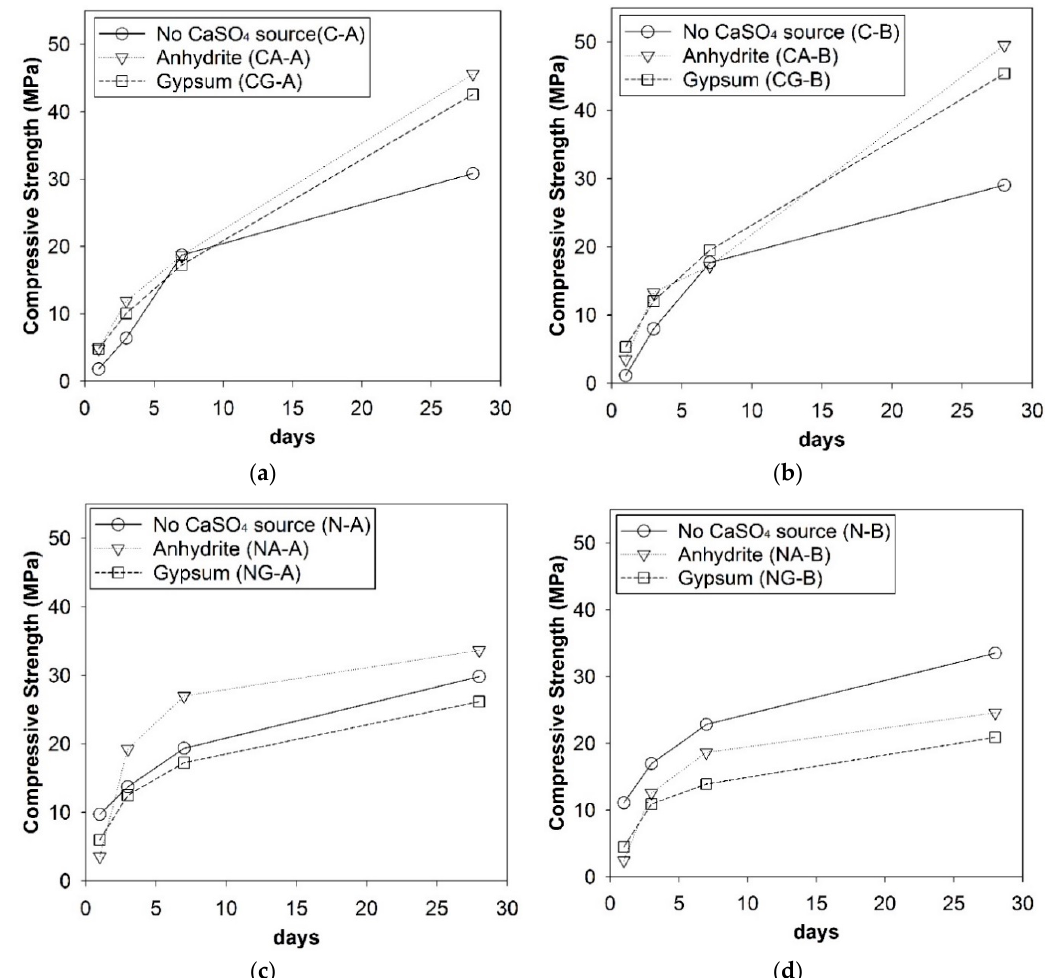
Figure 3. Compressive strength development of hardened paste samples with/without calcium sulfates: ( a ) CaO ‐ activated type A GGBFSs, ( b ) CaO ‐ activated type B GGBFSs, ( c ) NaOH ‐ activated type A GGBFSs, and ( d ) NaOH ‐ activated type B GGBFSs.